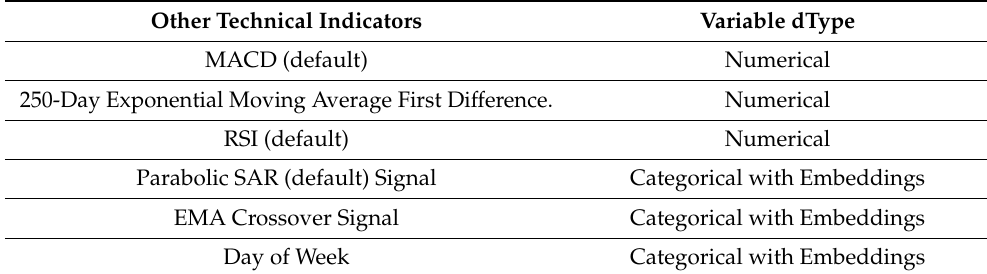
Table 2. Technical Indicators and Variable